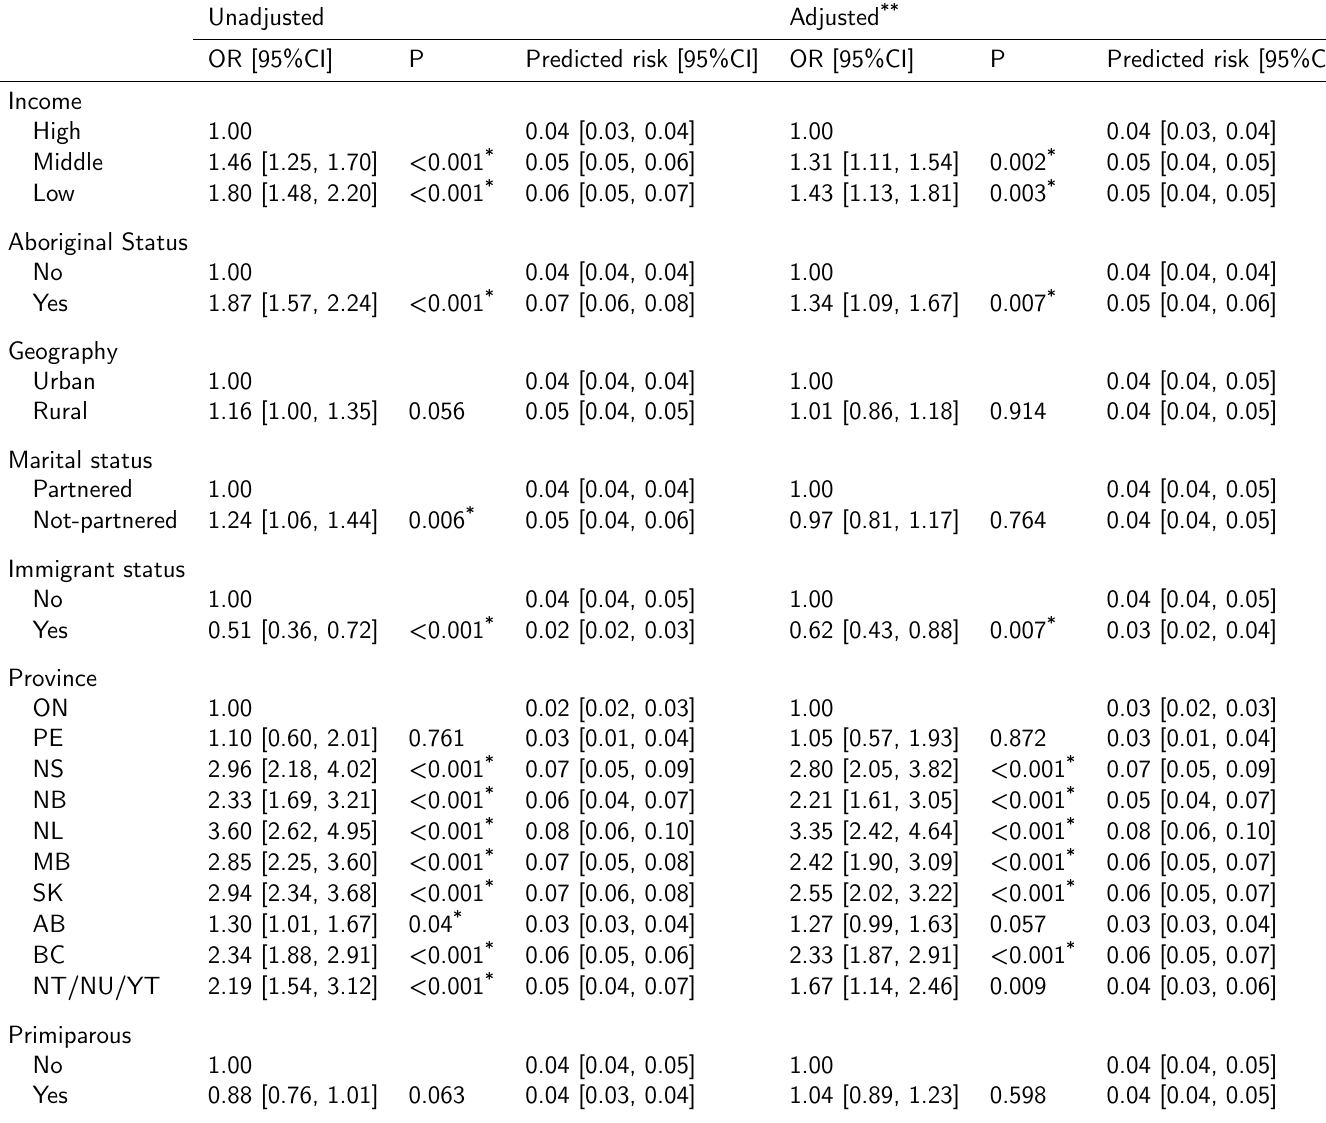
Supplementary Table 5: Odds ratios and risks of maternal admission within 30 days before delivery Risk of pre-delivery admission for all deliveries